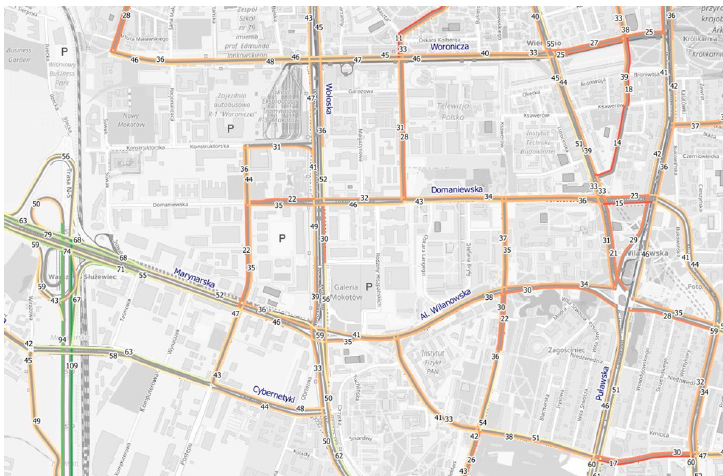
Figure 14. Average speed on the streets of “Mordor” during rush hours (based on simulation results for the variation of an auction with “patient” agents).